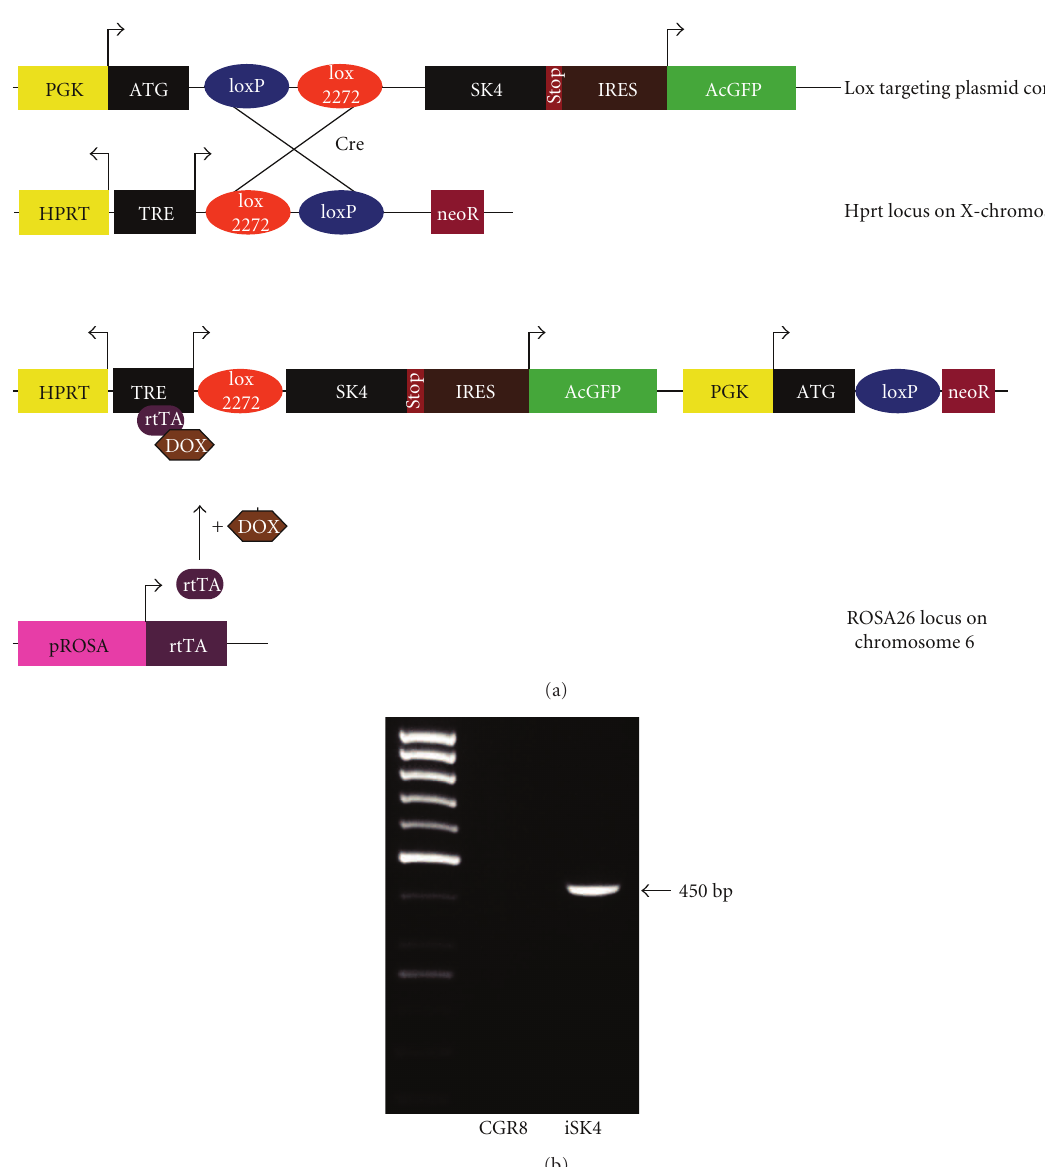
Figure 2: Construction of the iSK4 cell line. (a) Scheme of the expression cassette integrated into the desired loci. The ES cell line A2lox.cre harbors an rtTA in the constitutive ROSA26 locus on chromosome 6. A neomycin (noeR) resistance is recombined upon integration of the targeting vector. Recombination of the construct into the prepared site on the X-chromosome is facilitated by Cre. Transgenic cells can subsequently be selected by G418 (neo). tetOP: tetracycline response element; PGK: phosphoglycero kinase promoter; ATG: methionine initiation codon; black triangle: lox recognition sequence for Cre recombinase; GFP: green fluorescent protein; Neo: truncated neomycin (G418) resistance gene; pA: polyadenylation sequence. (b) Lox-in PCR verifies the correct integration of the expression cassette at determined loci on chr6 by amplifying a product at the size of ∼ 450 bp. Untargeted ES cells were used as a control.